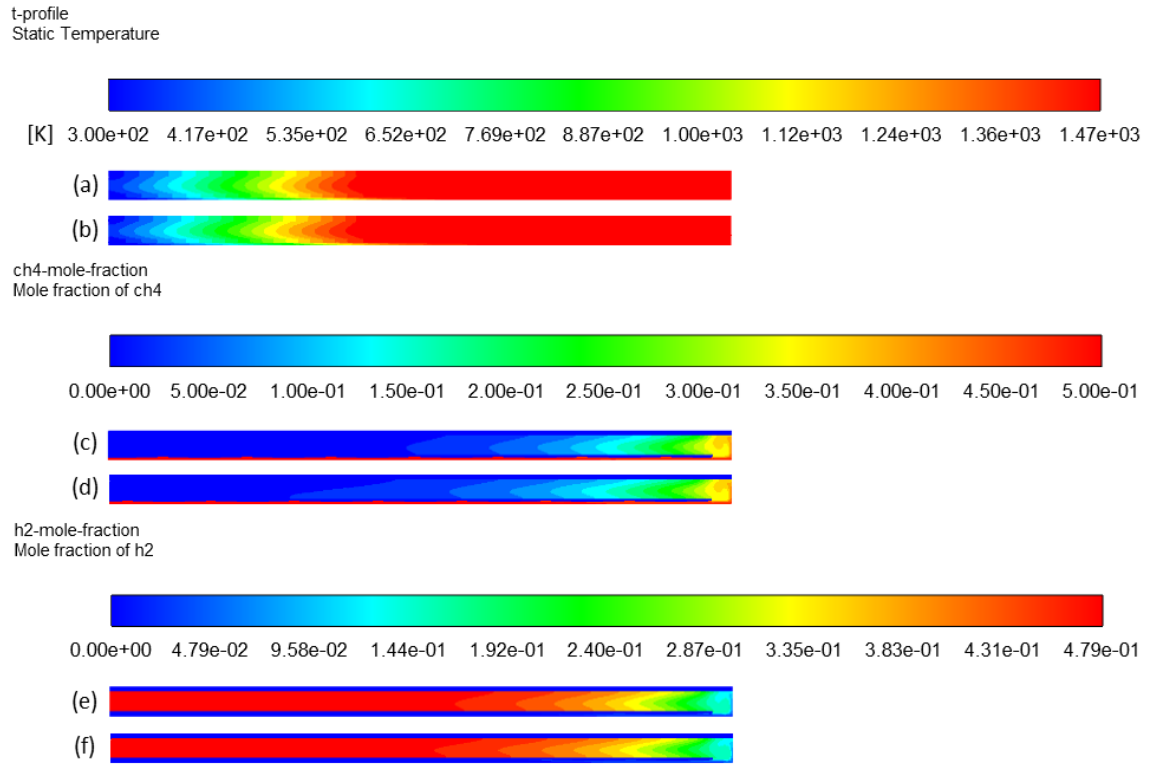
Figure 13. Effect of methane inlet mole fraction on temperature profile: ( a ) case 4 and ( b ) case 1; CH 4 mole fraction profile: ( c ) case 4 and ( d ) case 1; H 2 mole fraction profile: ( e ) case 4 and ( f ) case 1.